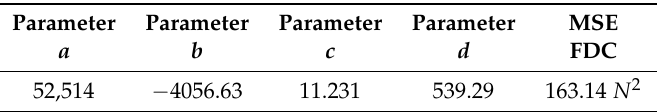
Table 2. Identified material parameters using LS-OPT for the simulation of the experimental specimen and the corresponding FDC MSE.